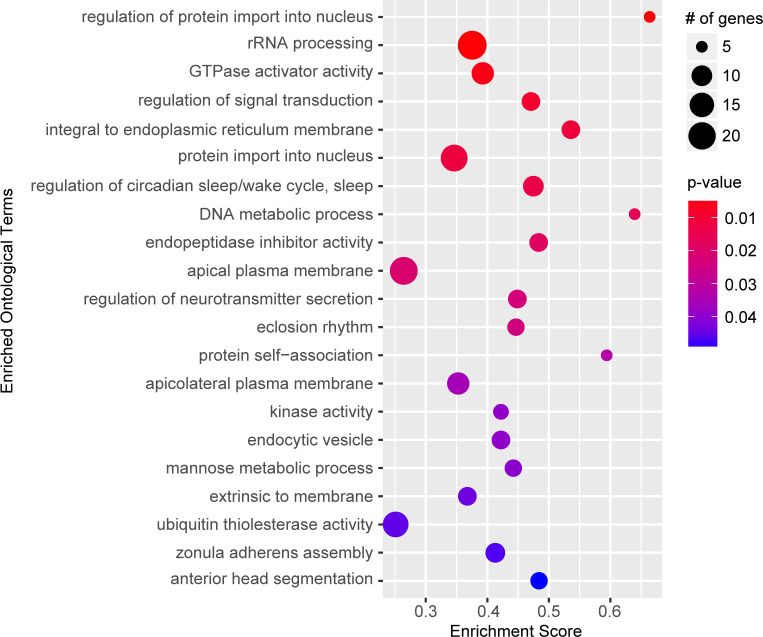
Gene set enrichment analysis.Top significant ontological categories identified by GSEA. p-values are indicated by red-to-blue gradient, with red the lowest p-values and blue the highest p-values. Gene number identified in each category is indicated by the size of the circle.